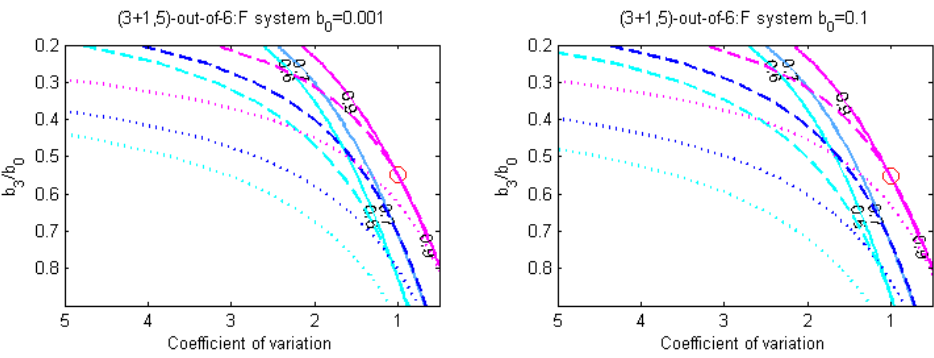
Figure 4. Level curves for m ∗